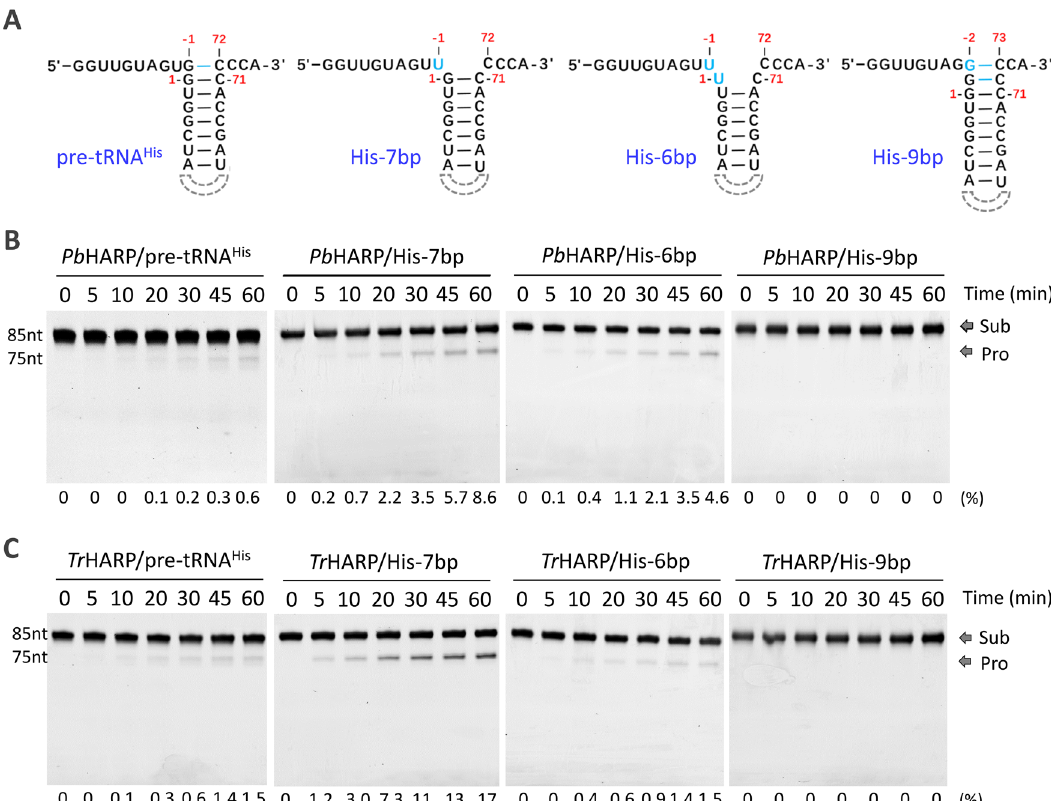
Fig. 5 Pre-tRNA His mutation and cleavage by HARP. A Sequence and secondary structure of 5 ’ -end, acceptor stem and 3 ’ -end of the native and mutated pre-tRNA His . B In vitro cleavage assays using 1 μ M pre-tRNA and 0.05 μ M Pb HARP. C In vitro cleavage assays using 1 μ M pre-tRNA and 0.05 μ M Tr HARP. The substrate cleavage percentage (%) is shown at the bottom of the gels. Experiments were repeated independently three times ( B , C ) with similar results. Source data are provided in Source Data fi